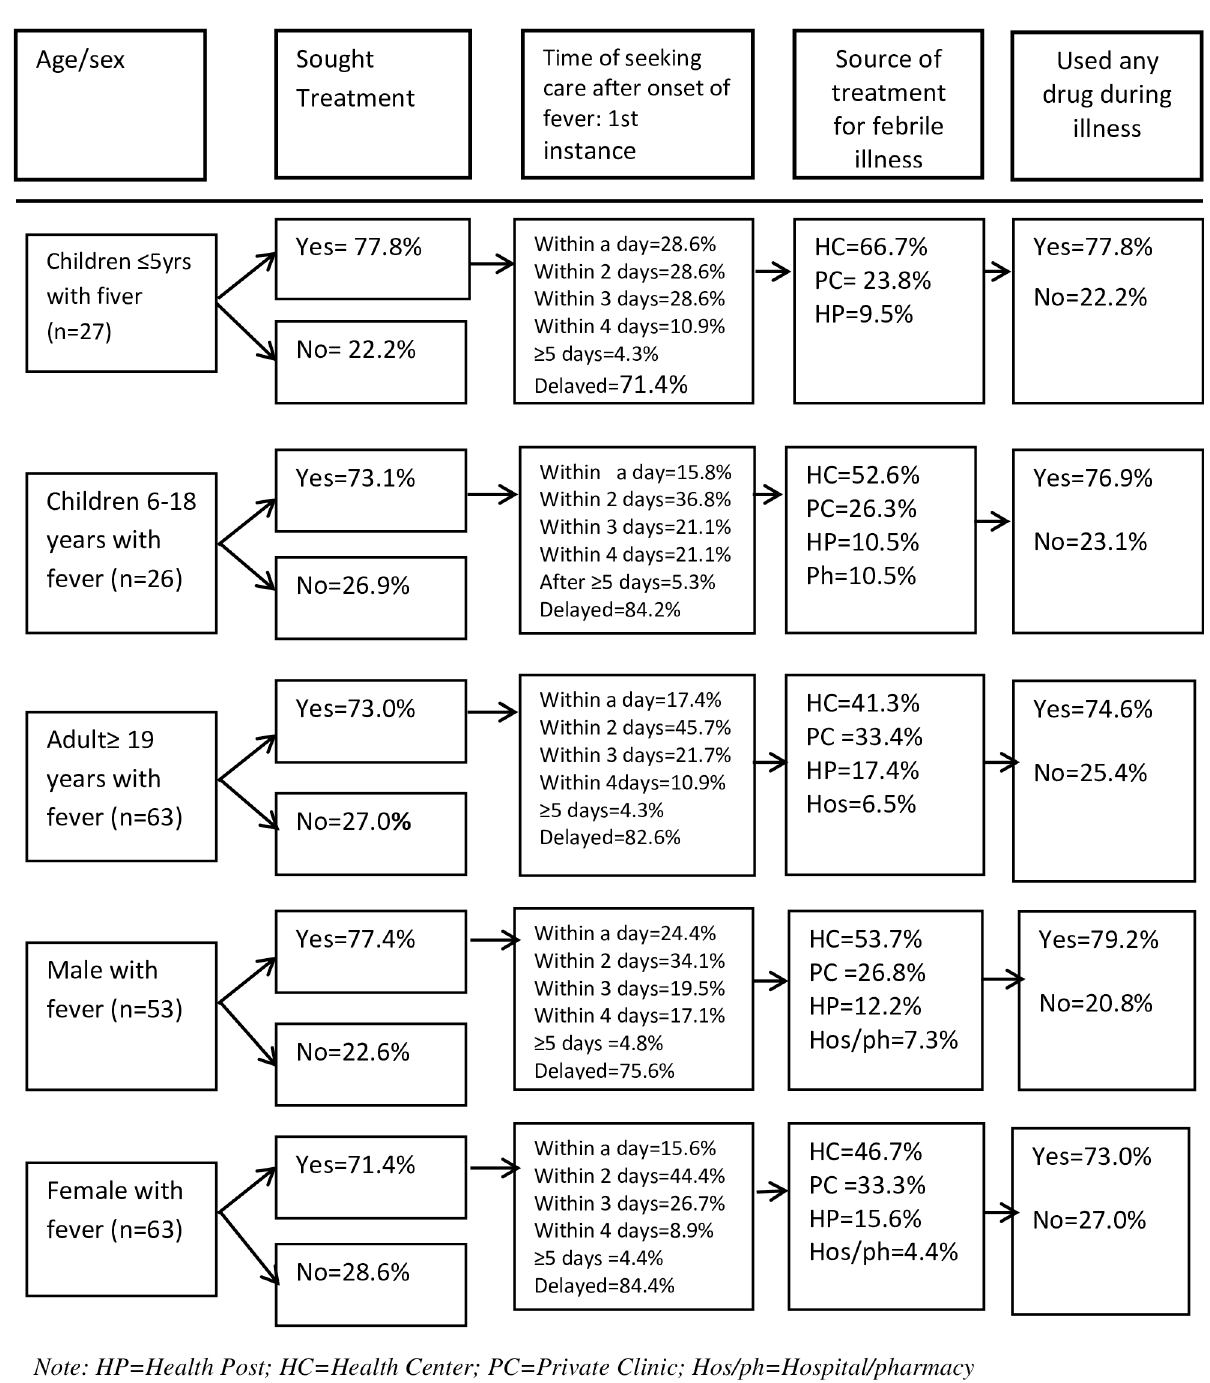
Fig 3. Pattern of seeking care after onset of fever by age and sex category, Jimma, Jan 2014. The frequency of seeking any care for fever was almost similar across age groups even though slightly higher for children under five (77.8%) as compared to other age groups. However, there was a slight gender disparity (male 77.4% versus female 71.0%). On the other hand, the frequency of seeking prompt care was relatively higher for children below the age five (28.6%) and lower for older children (age 6 – 18 years old) (15.8%). Likewise, more males (24.4%) were promptly taken to health facilities than females (15.6%) within a day. The frequency of using public health facilities tended to decline with age while the tendency of using private clinics increased with age which means that respondents tended to visit public health facilities for childhood fever whereas private clinics were chosen for adulthood fever (private clinic: 23.8% for children versus 33.4% for adults).